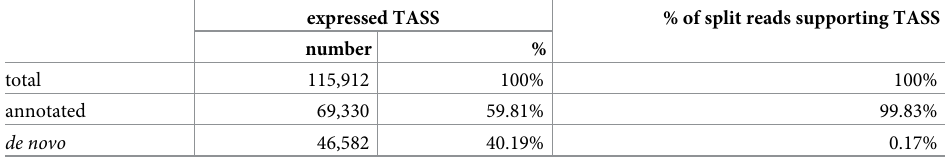
Table 1. Abundance and split read support of annotated and de novo TASS.